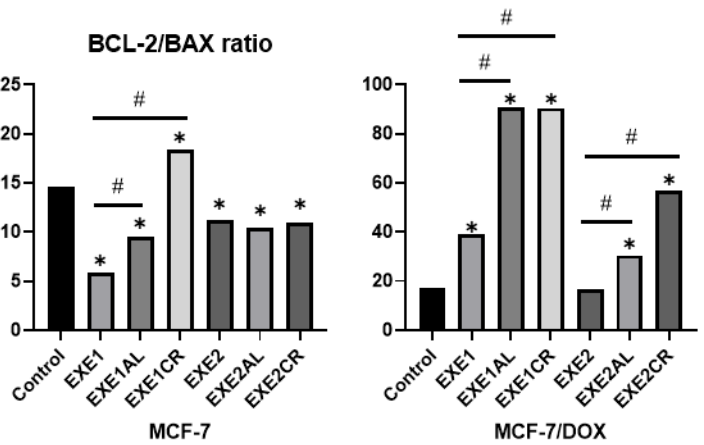
Figure 6. The effect of exemestane and its combination with metalloestrogens in the Bcl-2/BAX ratio. EXE1 = 100 µM; EXE2 = 200 µM; and Al/Cr(III) = 100 µM. The results are presented as mean, n = 3; p < 0.05; * statistically significant difference from control; # statistically significant difference from aromatase inhibitor alone. Table 3. Bcl-2/BAX ratio values in MCF-7 and MCF-7/DOX cell lines after exposure to exemestane alone or in combination with metalloestrogens. The results are presented as mean, n = 3; p < 0.05.